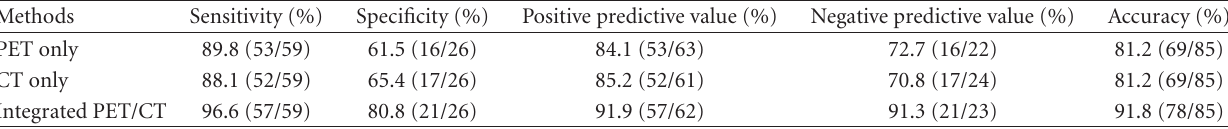
Table 1: The diagnostic value of PET only, CT only, and integrated PET/CT on 85 patients with lung